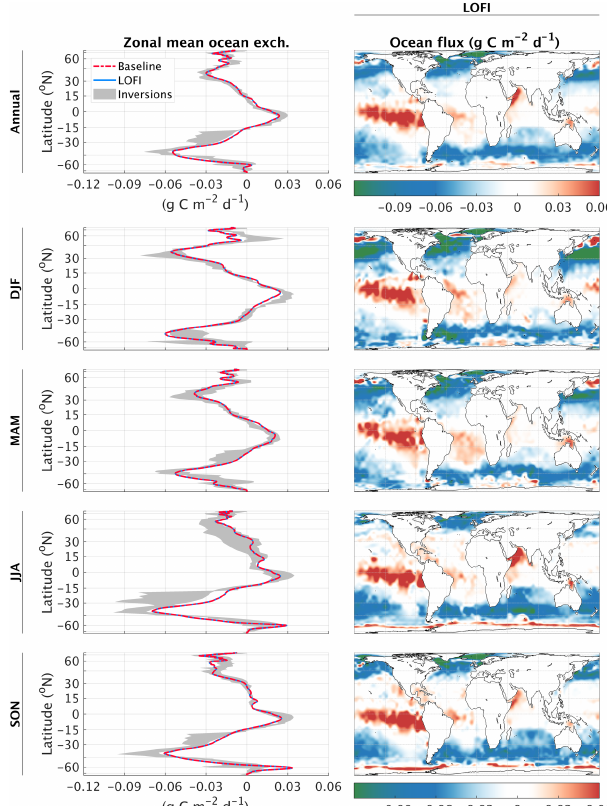
Figure A1. Climatologies (2003–2015) of ocean exchange from the LoFI fluxes. The first row represents annual averages, and each sub- sequent row represents averages over different seasons. The left col- umn depicts zonal means from the LoFI fluxes (dash–dot red) and the ranges of zonal means from the inversion ensemble (dark grey), and the right column shows seasonal gridded maps of the diagnostic